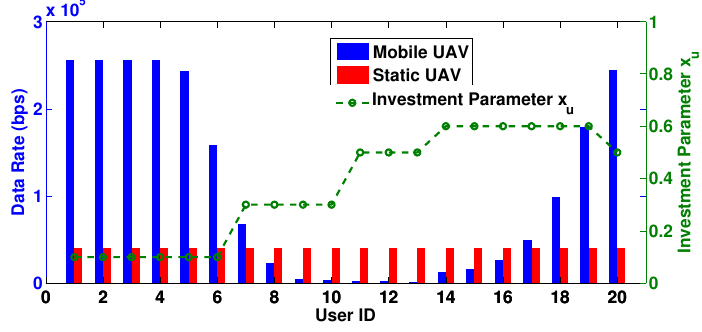
Figure 2. Data rates and power investment per user